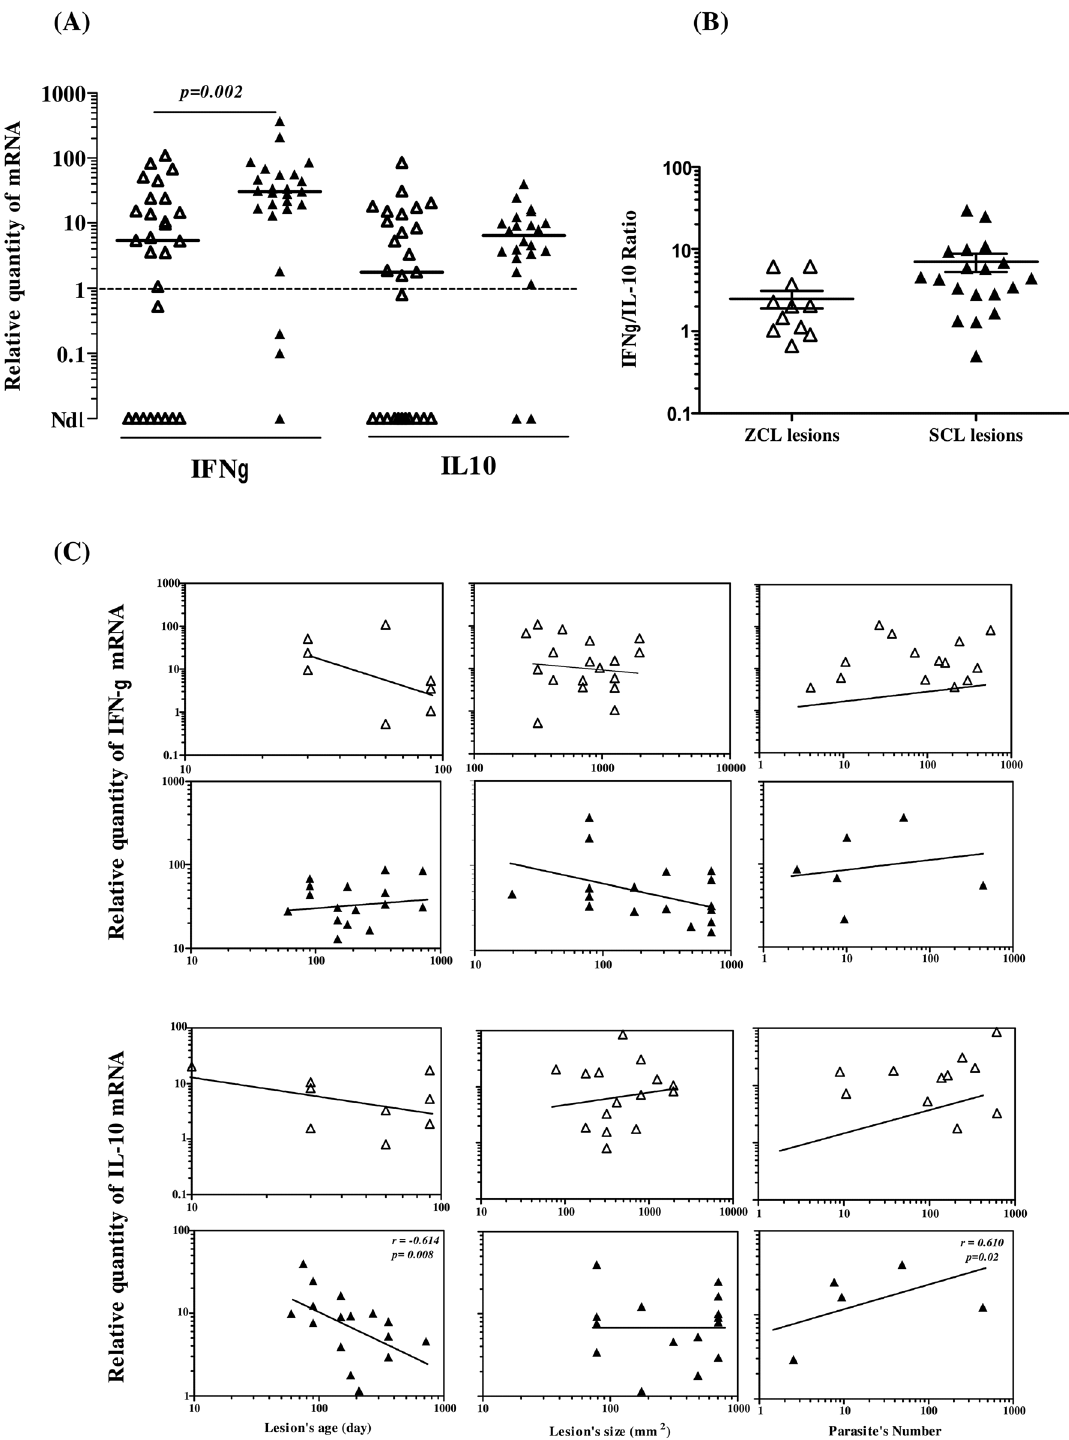
Figure 3. IFN- c and IL-10 mRNA expression within ZCL and SCL lesions. (A) Dot-plots show individual values of IFN- c or IL-10 mRNA expression within ZCL ( D ) and SCL ( N ) lesions. A horizontal bar indicates the median for each group. Results are expressed as the ratio between levels of cytokine mRNA in samples studied to those detected in normal skin. Differences between groups were considered statistically signi fi cant when p < 0.05. Nd: not detected. (B) Dot-plots show the ratio of IFN- c /IL-10 mRNA levels calculated for each lesion. Horizontal bars indicate mean and the standard error of mean (SEM) for each group. (C) Correlation between IFN- c or IL-10 mRNA levels and the age of lesions, their size, and the number of parasites they contain. Correlations between different variables were evaluated with the Spearman ’ s rank correlation test, r: correlation coef fi cient; p < 0.05 was considered statistically signi fi